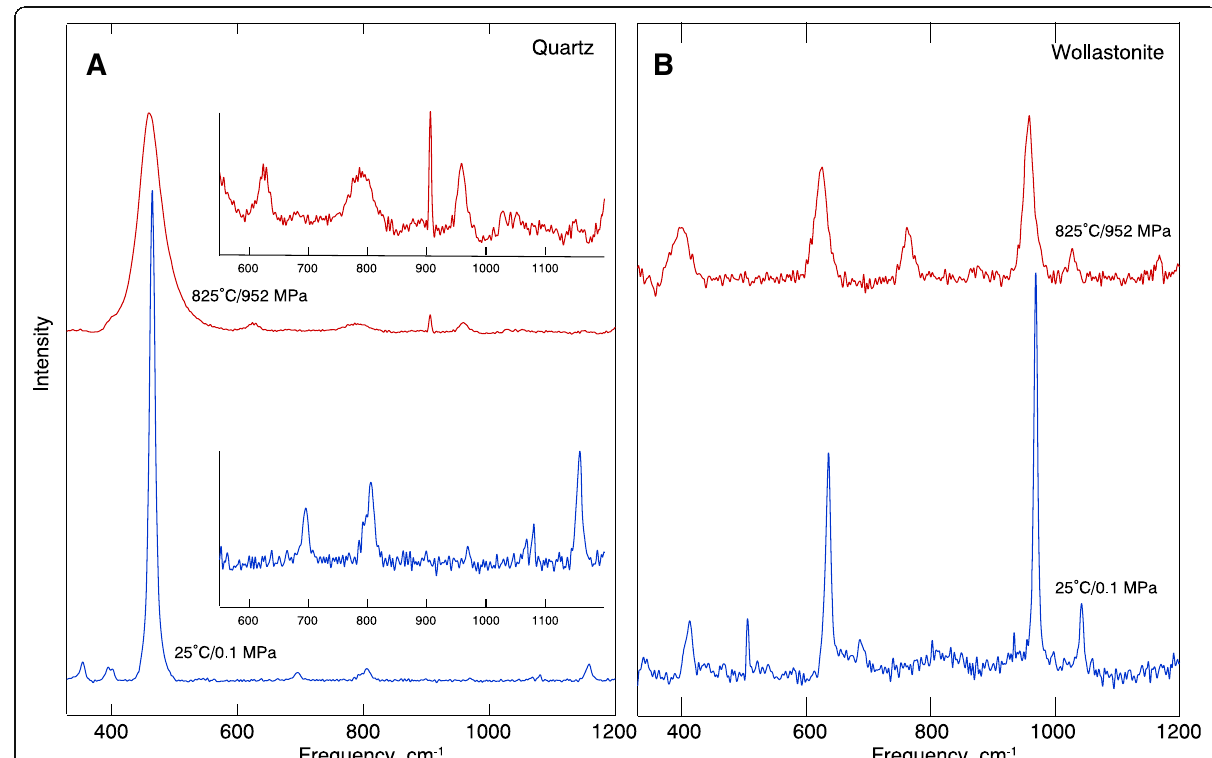
Fig. 2 Raman spectra of crystalline quartz ( a ) and wollastonite ( b ) from the system SiO 2 – CaO – H 2 O at 825 °C/952 MPa and ambient